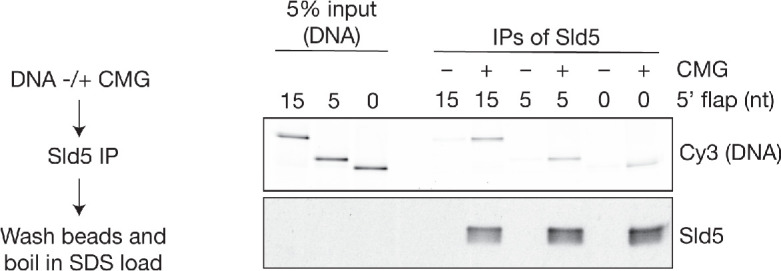
Association of the CMG helicase with model DNA replication forks.Recombinant CMG helicase was mixed with Cy3-labelled versions of the DNA substrates shown in Figure 2C (i), and then incubated for 60 min on ice. The CMG helicase was isolated by immunoprecipitation of Sld5, before immunoblotting and detection of Cy3 fluorescence.